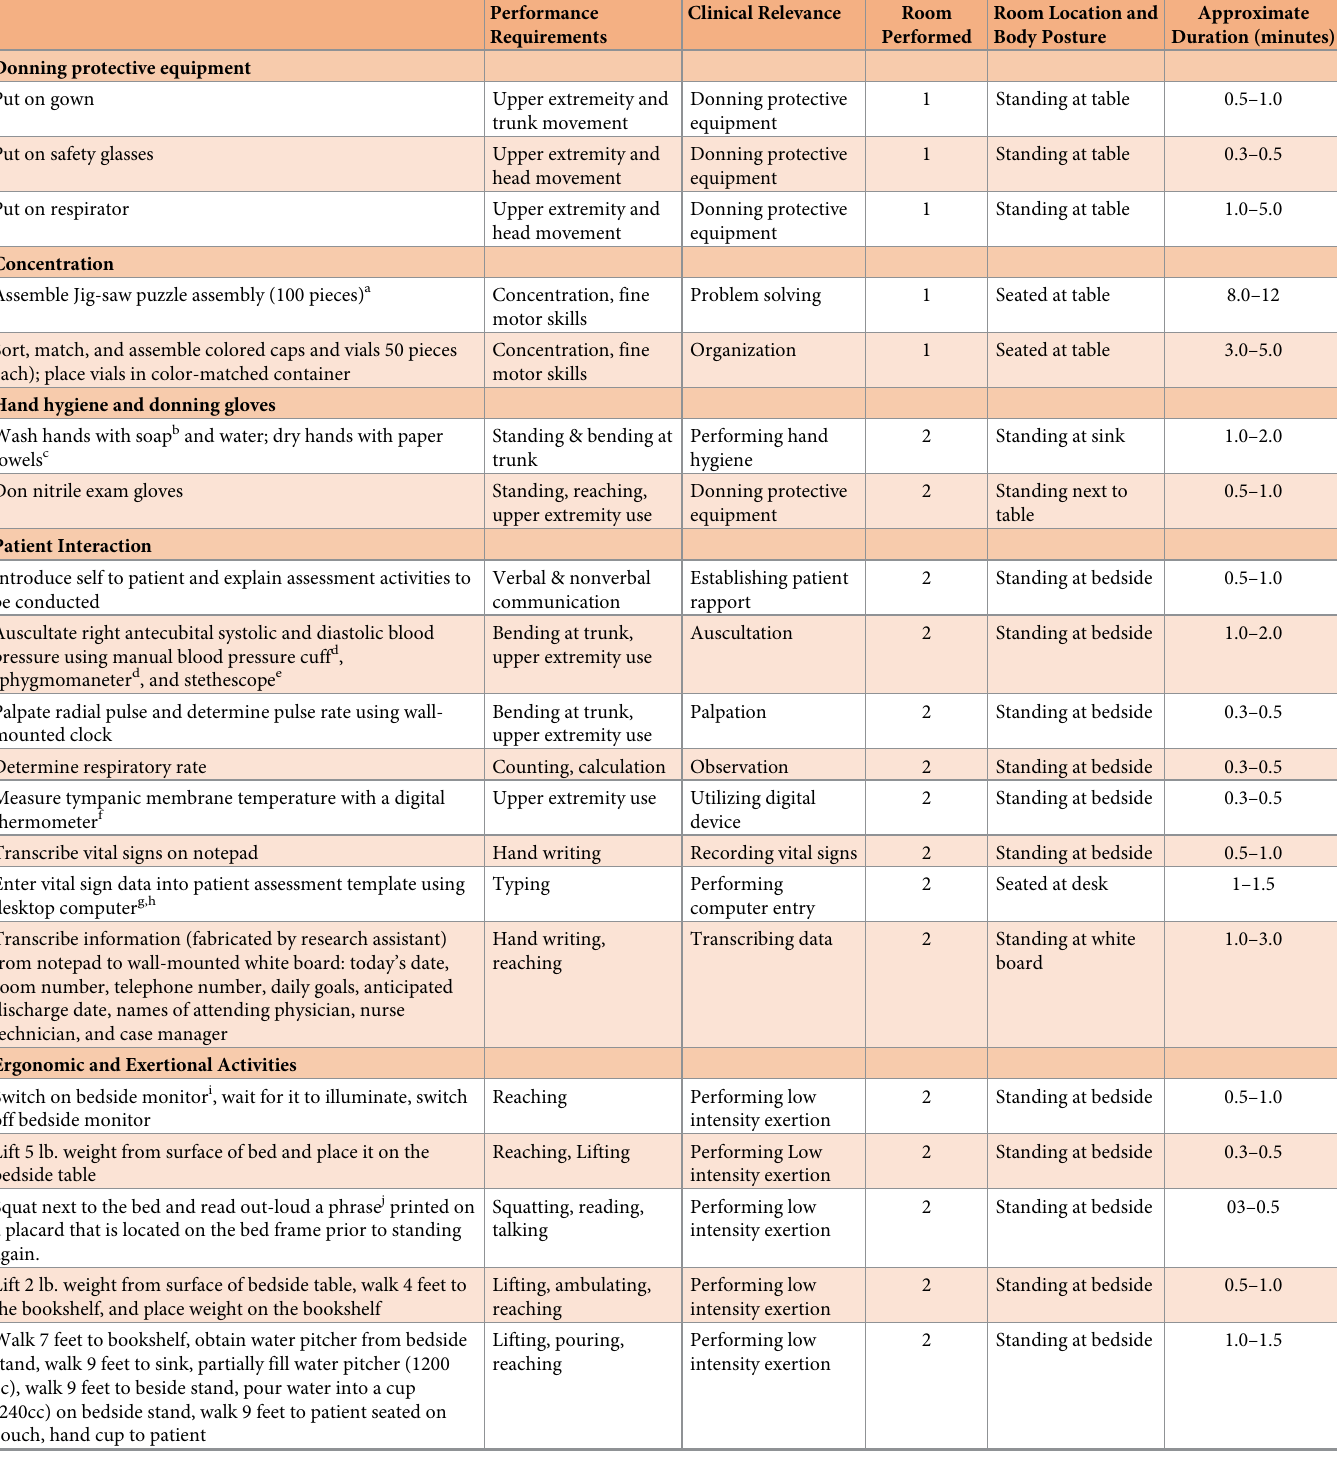
Table 3. Simulated workplace activities, tasks, and approximate